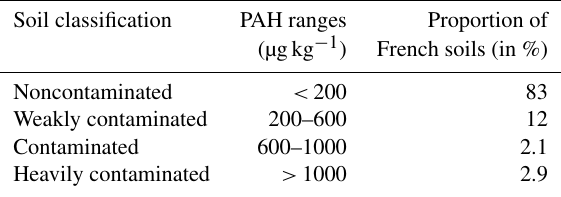
Table 5. The soil contamination classification suggested by Maliszewska-Kordybach (1996) and a design-based estimation of the proportion of associated French